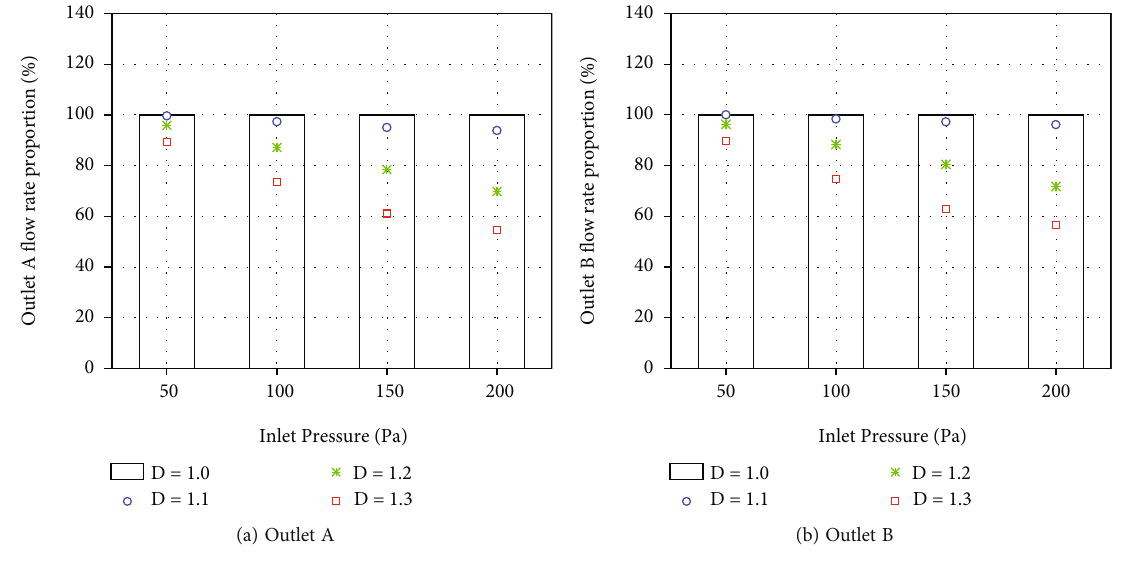
Figure 4: Evolution of outlet fl ow rate proportion with inlet pressure.